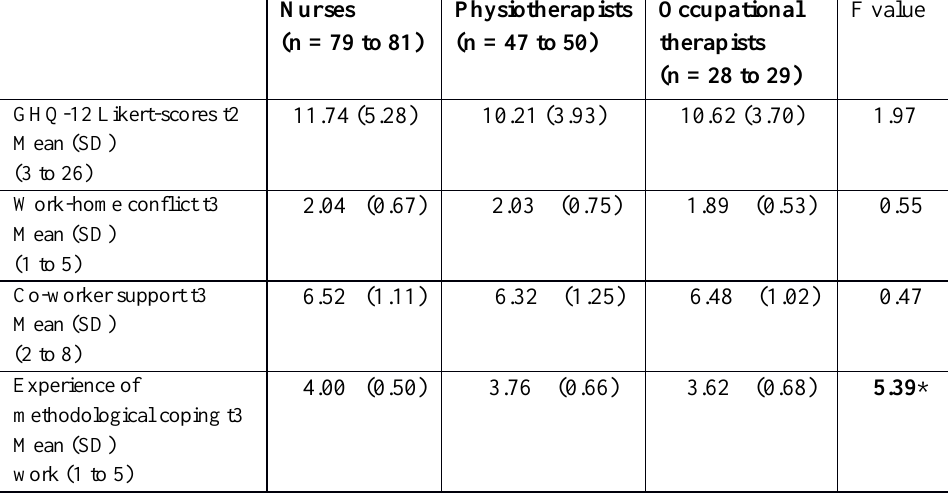
Table 3 Mean, SD and N for each of the Groups on the Variables of GHQ-12 Likert at t2 and Work-Home Conflict, Co-Work Support and Experience of Methodological Coping at Work at